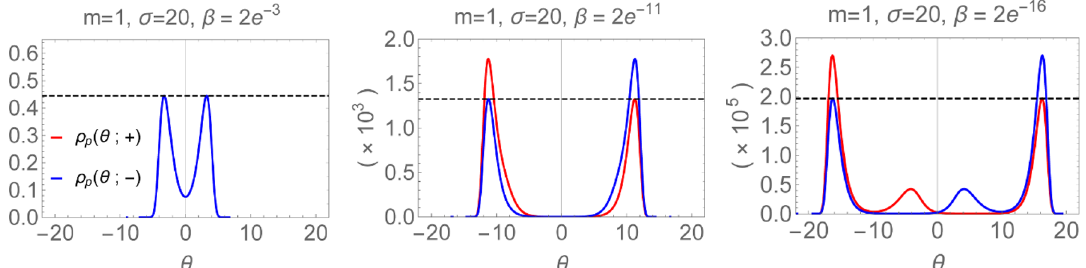
Figure 4 . Spectral densities for three values of the temperature: (cid:12) = 2 e (cid:0) 3 ; 2 e (cid:0) 11 and 2 e (cid:0) 16 . In the two rightmost panels, the vertical axis labels should be multiplied by factors 10 3 and 10 5 , respectively, as indicated. In all panels, a dashed horizontal line indicates the height of the free- fermion peak, 0 : 04431 : : : =(cid:12) . For low temperatures (left panel) we observe the free fermion result; for intermediate temperatures (middle panel) we observe the onset of the unstable particle with one of the peaks growing beyond the free fermion value; for high temperatures (right panel) the densities develop one additional local maximum. The evolution of the densities as functions of temperature can be further explored in this video